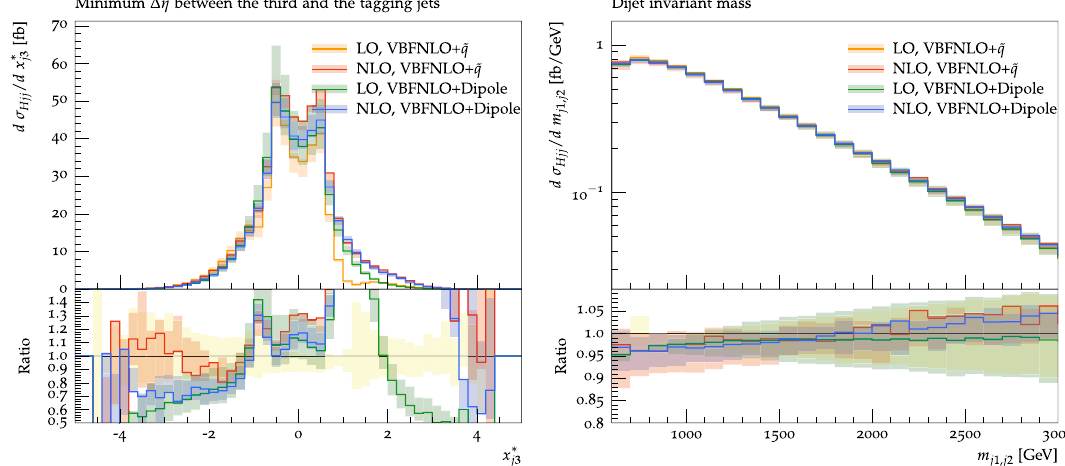
Fig. 10 Relative pseudo-rapidity difference between the third jet and the tagging jets (left) and tagging jet invariant mass (right). We use the setup of HERWIG7 + VBFNLO within the tight VBF selection of Sect. 4.1.3 and compare the dipole and angular ordered showers